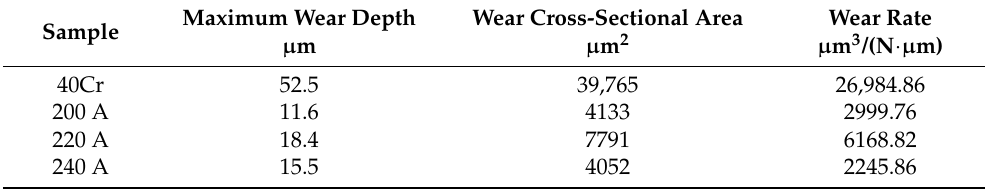
Table 2. Wear resistance test results of the base material and the high-entropy alloy coating of FeCrMnCuNiSi 1 with different melting